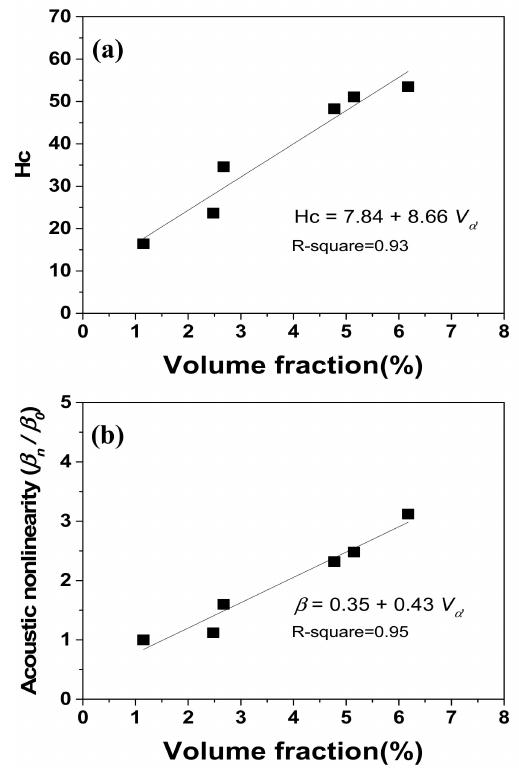
Figure 12. A linear relationship between acoustic nonlinearity and magnetic coercivity as a function of the volume fraction of α (cid:48) -martensite: ( a ) magnetic coercivity and ( b ) acoustic